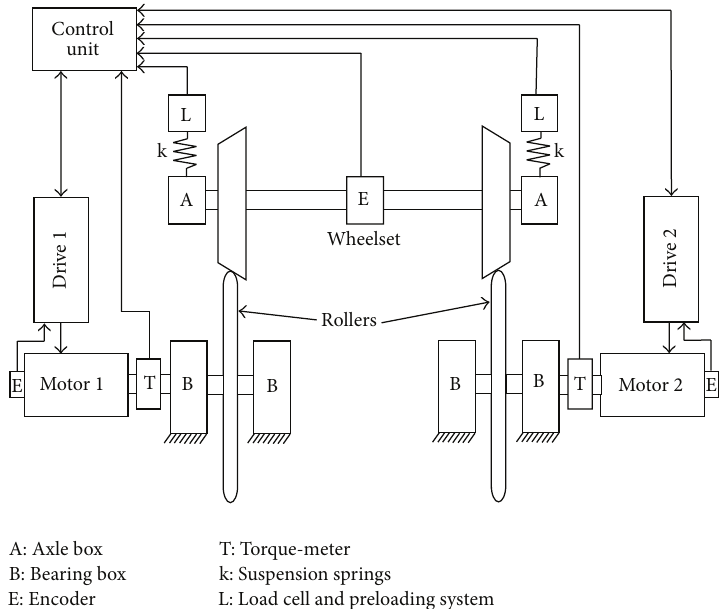
Figure 1: Schematic of the roller rig with a single suspended wheelset.